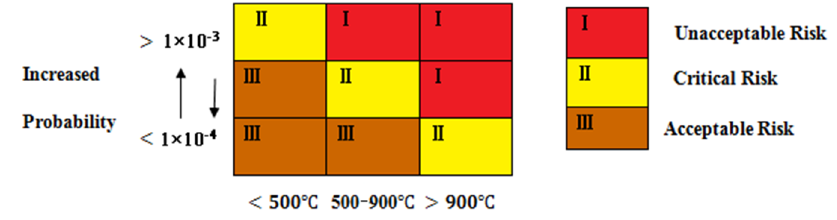
Figure 2. Risk matrix.